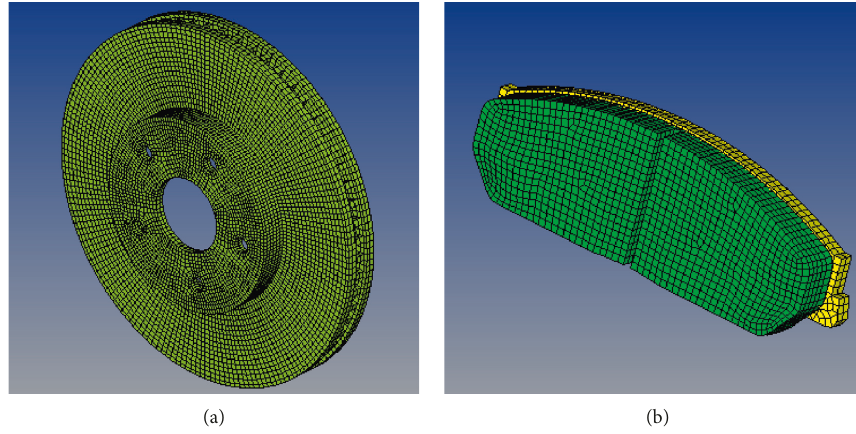
Figure 2: Mesh models of (a) the brake disc and (b) the